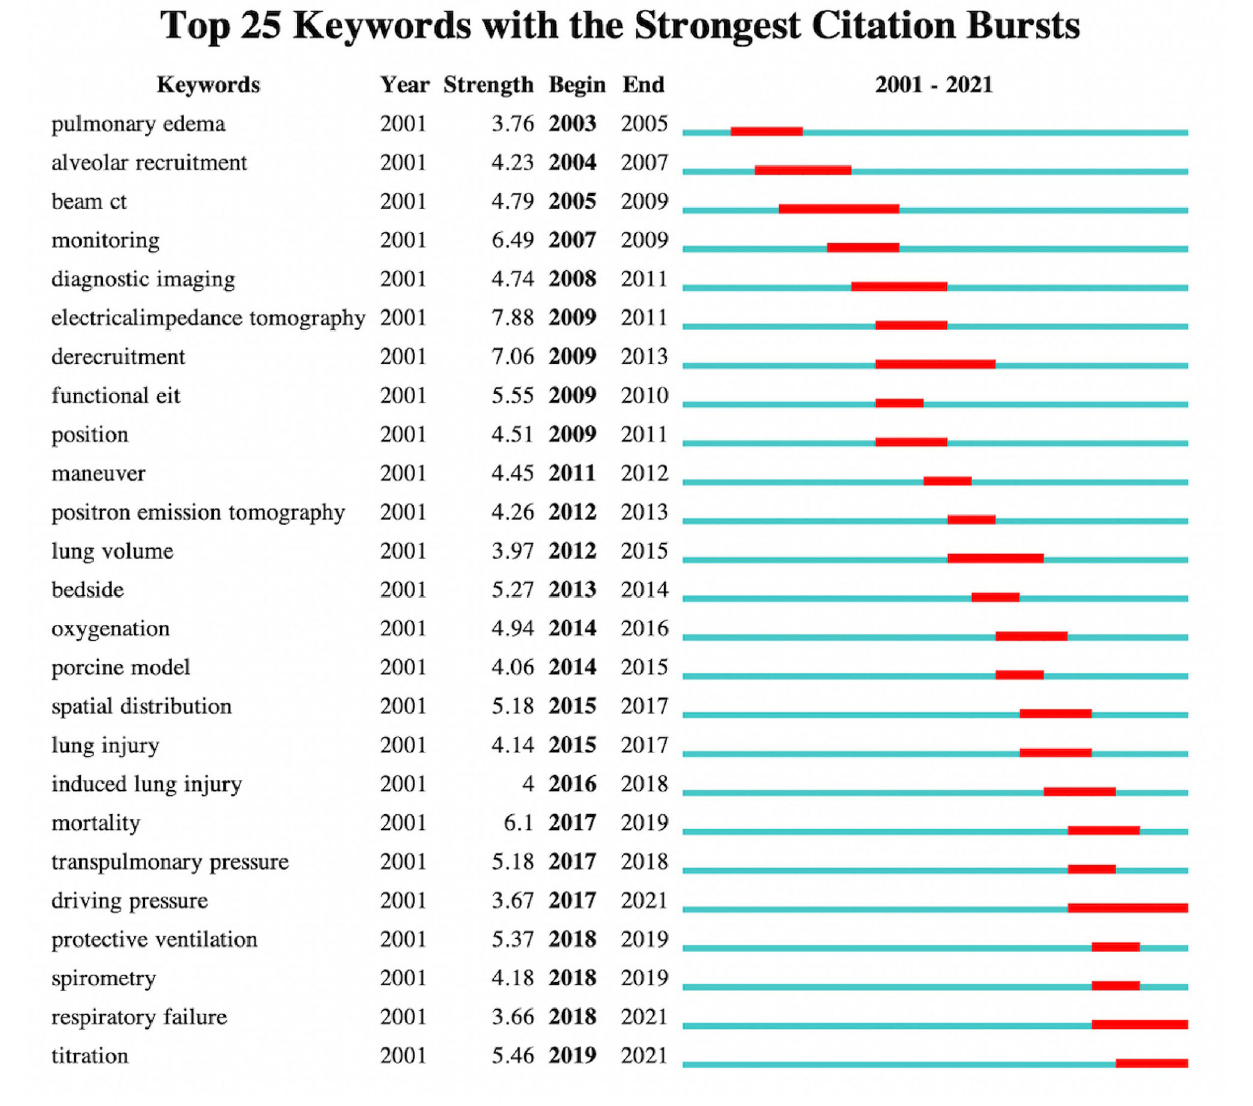
publication “Frerichs I, 2017, THORAX” (12) (strength